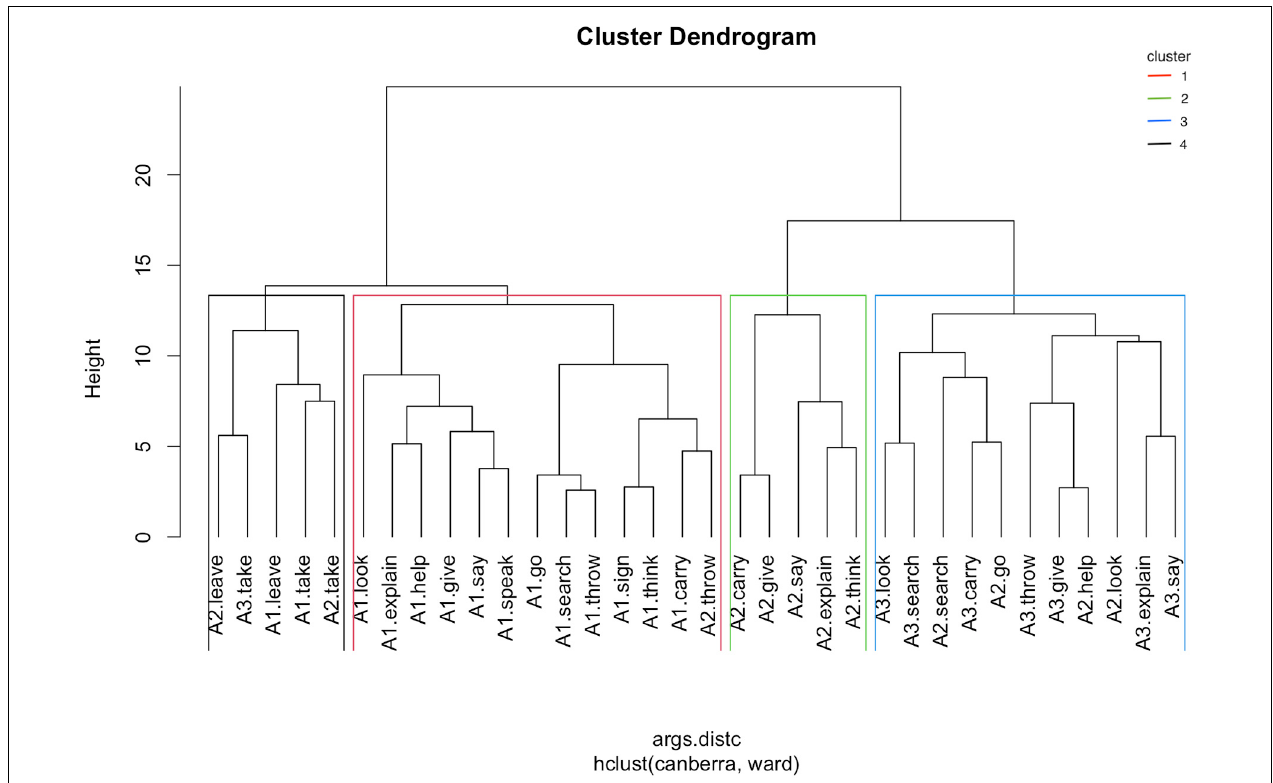
FIGURE 3 | Cluster dendrogram of argument